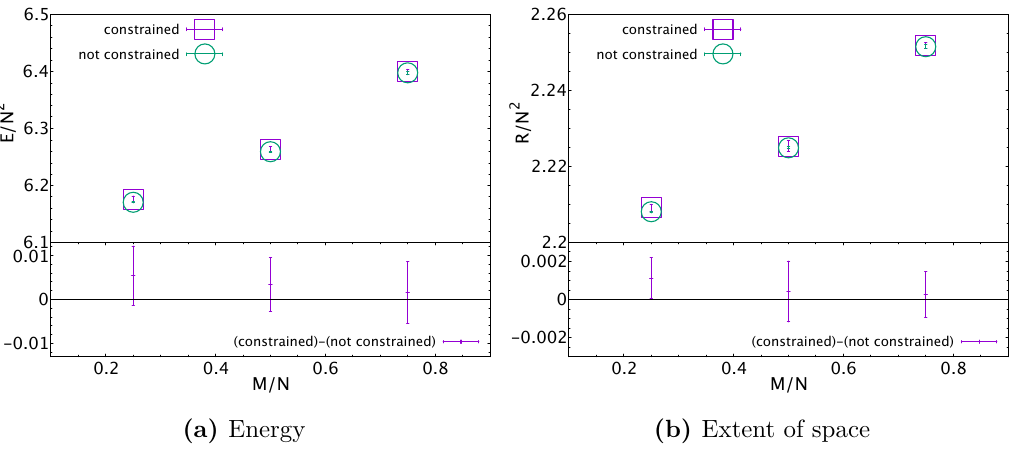
Figure 14. Yang-Mills matrix model, N = 64 , L = 24 , and T = 0 . 885 . Comparison between observables from simulations with and without the constraint term (4.11). The error bars in each figure are obtained by jackknife